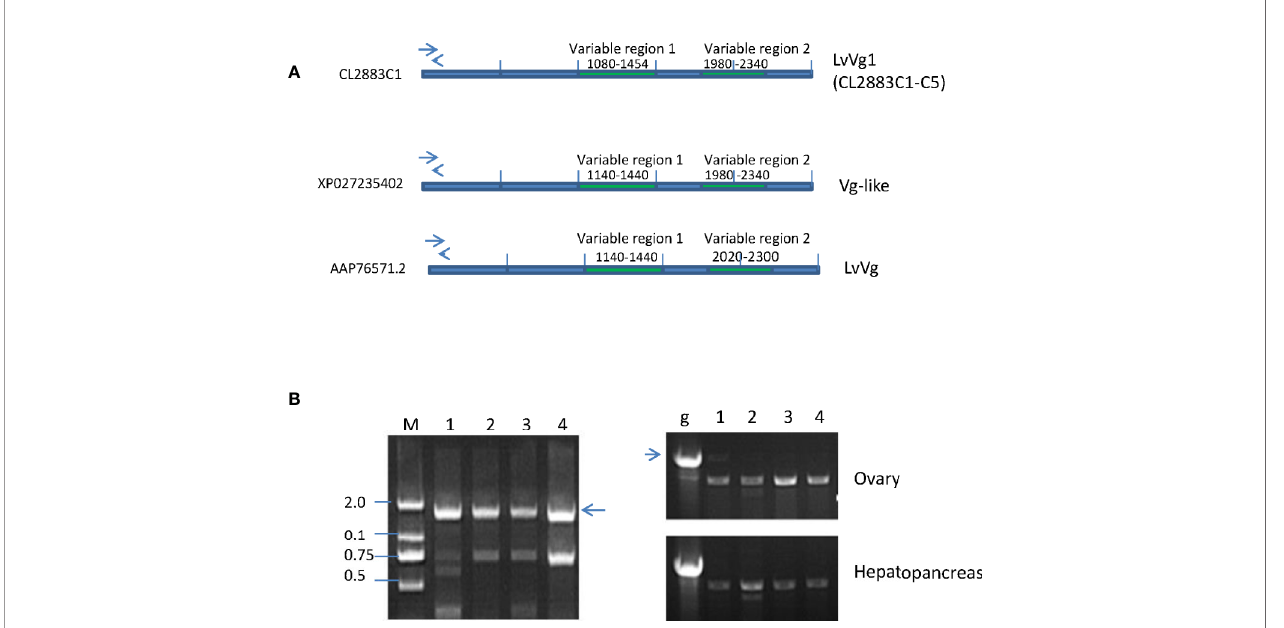
FIGURE 2 | Comparison and con fi rmation of LvVg1 genes isolated from the transcriptomic study with previously reported Vg (Genbank# XP027235402) and Vg -like (GenBank# AAP76571) genes in the whiteleg shrimp L. vannamei . (A) The LvVg1 transcripts (i.e.CL2283C1-C4) shared high degree of amino acid sequence identity (>97%) in the Vitellogenin-N domain, DUF1943, and VWB domain but only low degree of identity (50 – 56%) in the VR1 and VR2 regions. Arrows indicate location of the primers used to distinguish different LvVg1 isoforms. (B) Left panel: Genomic PCR detection of multiple LvVg1 genes from hepatopancreas derived gDNA of a single female. Lane M: 2 kb size marker; lanes 1 – 4 are gDNA ampli fi ed by primers speci fi c to LvVg1a , LvVg1b , LvVg1c , and LvVg1d , respectively. The arrow indicates the expected genomic DNA ampli fi ed by the speci fi c primers. Right panel: RT-PCR ampli fi cation of ovary and hepatopancreas cDNA. Lane g shows the PCR result of the genomic DNA (arrow) using one of the primer-pairs mentioned above. Lanes 1 – 4 are RT-PCR result using the corresponding four pairs of gene speci fi c primers. All transcripts (C1 to C4) can be detected in the ovary and hepatopancreas, con fi rming that at least four copies of LvVg1 genes are present in the shrimp